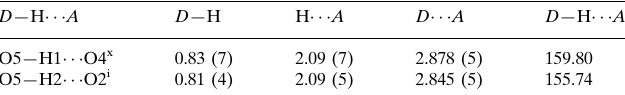
Hydrogen-bond geometry (A˚ , (cid:4)